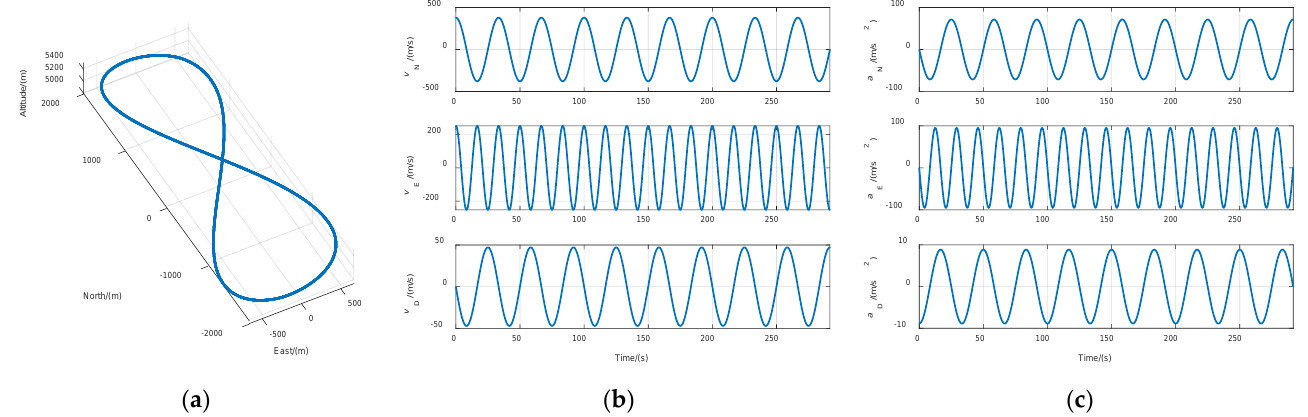
Figure 10. Simulated trajectory curves. ( a ) 3D position; ( b ) velocity; ( c ) acceleration.